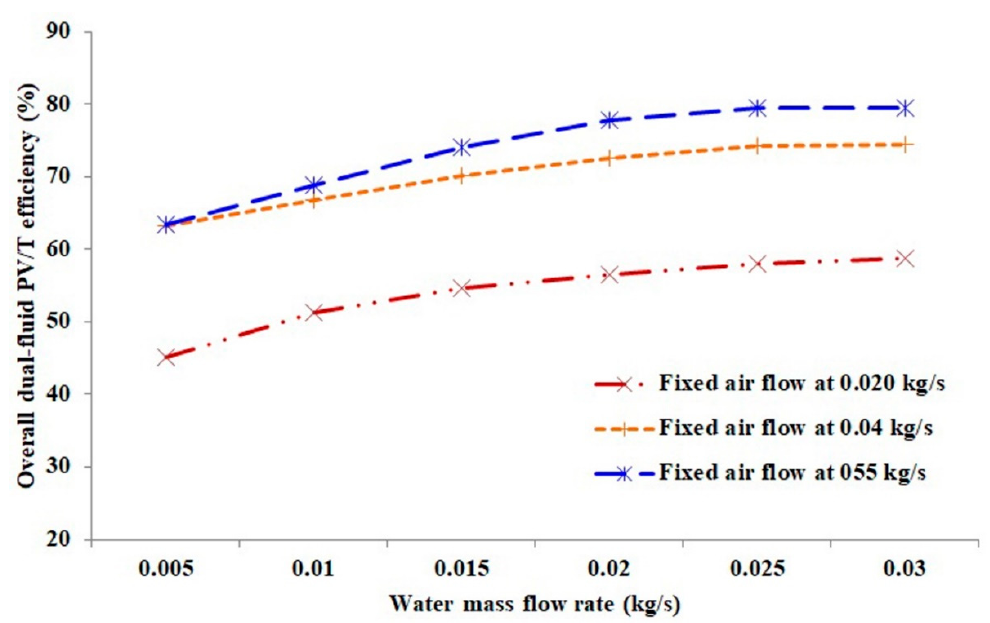
Figure 3. Variations of overall efficiency of the dual-fluid PV/T system at variable air flow rate and fixed water flow rate.